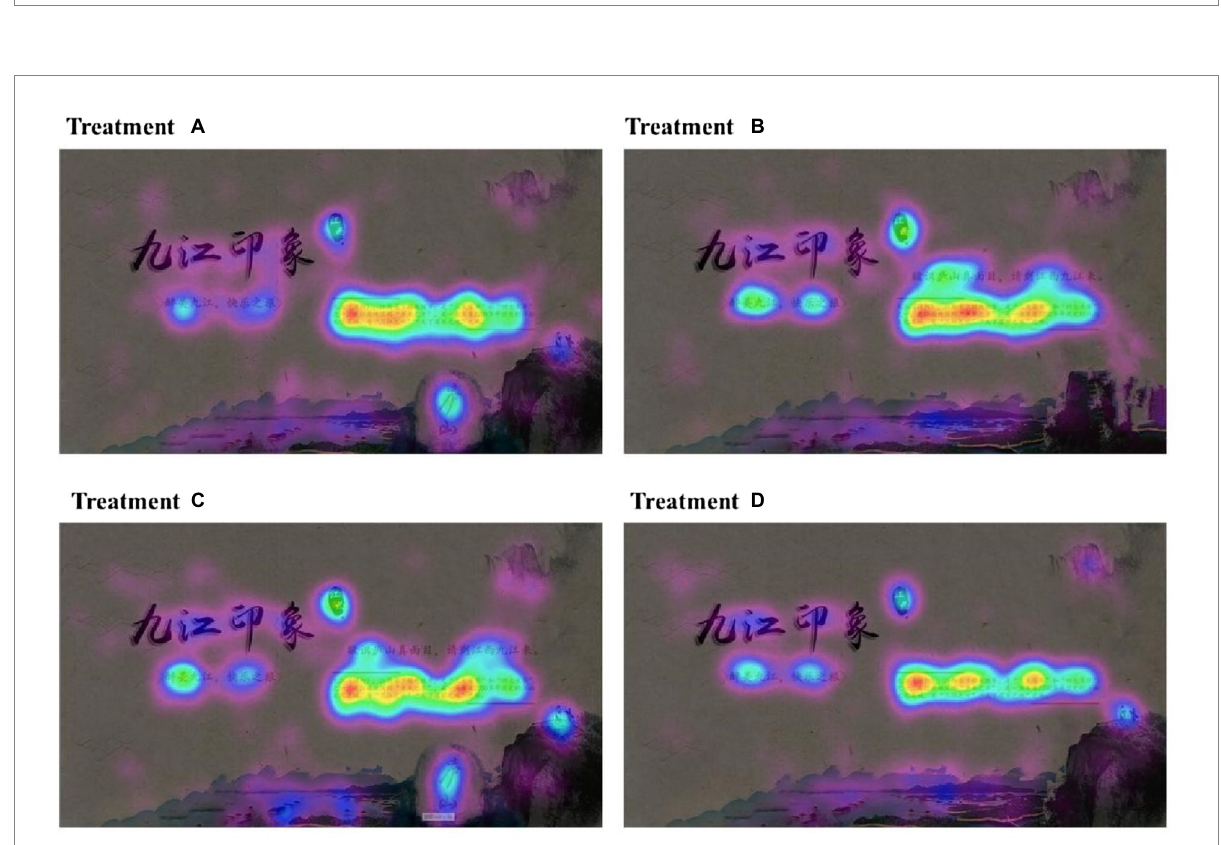
FIGURE 6 Heat map for eye movement. Source: EyeSo Studio software.